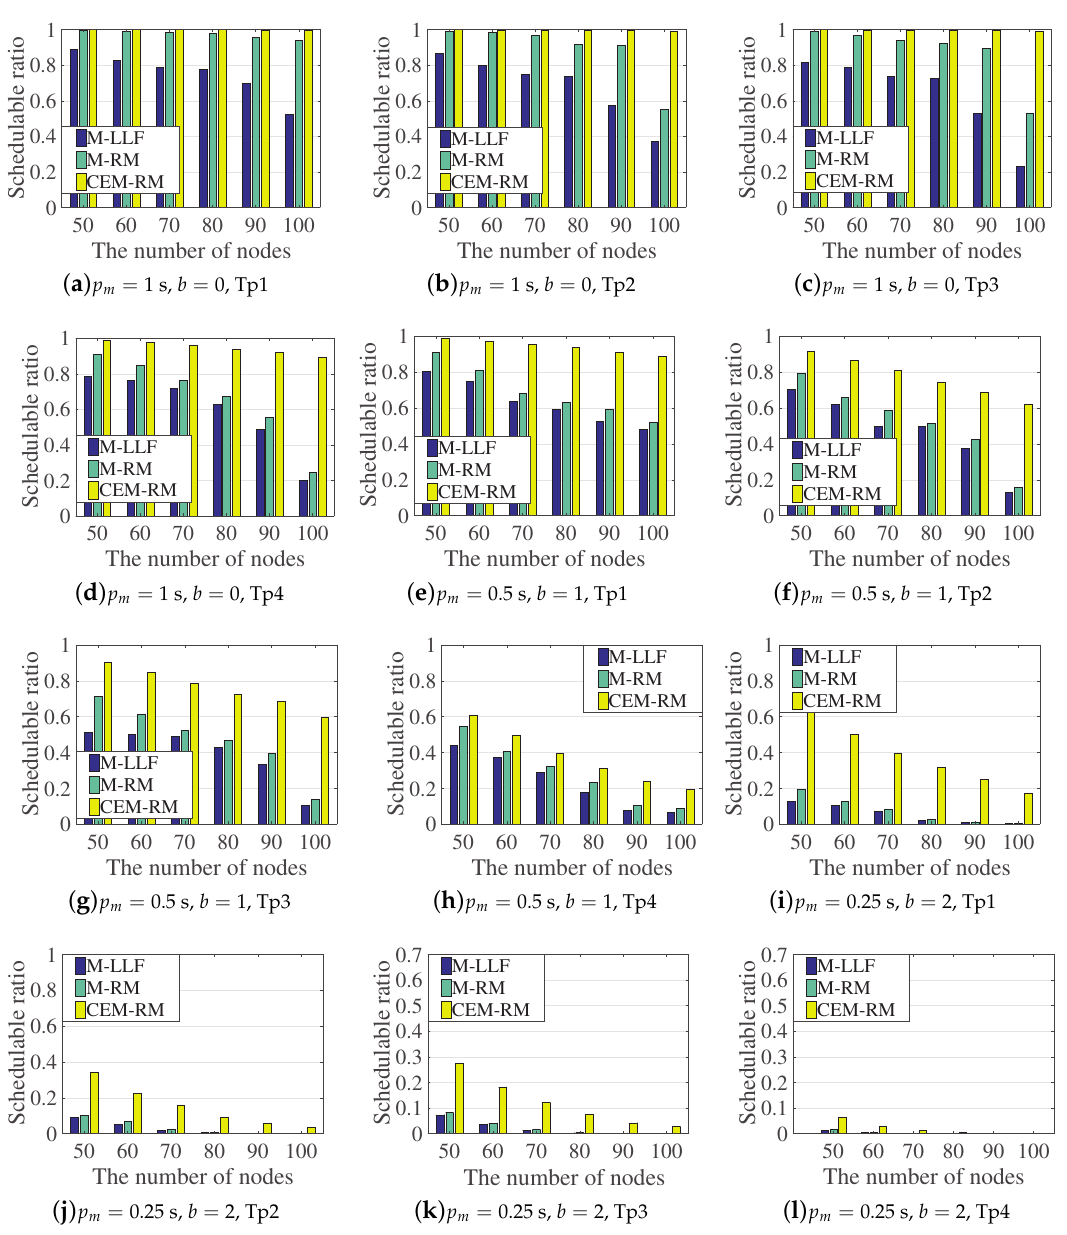
Figure 6. A comparison of the schedulable ratios of the three algorithms with different periods and